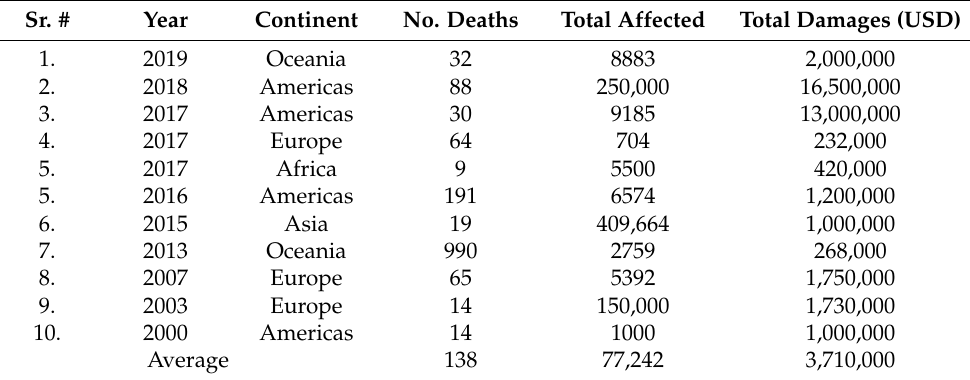
Table 1. Global wildfire events and their impact (from